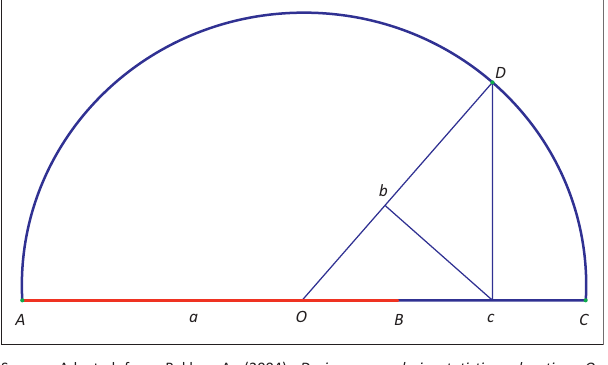
FIGURE 1: Theorem of Pappus: OD is the arithmetic mean of AB and